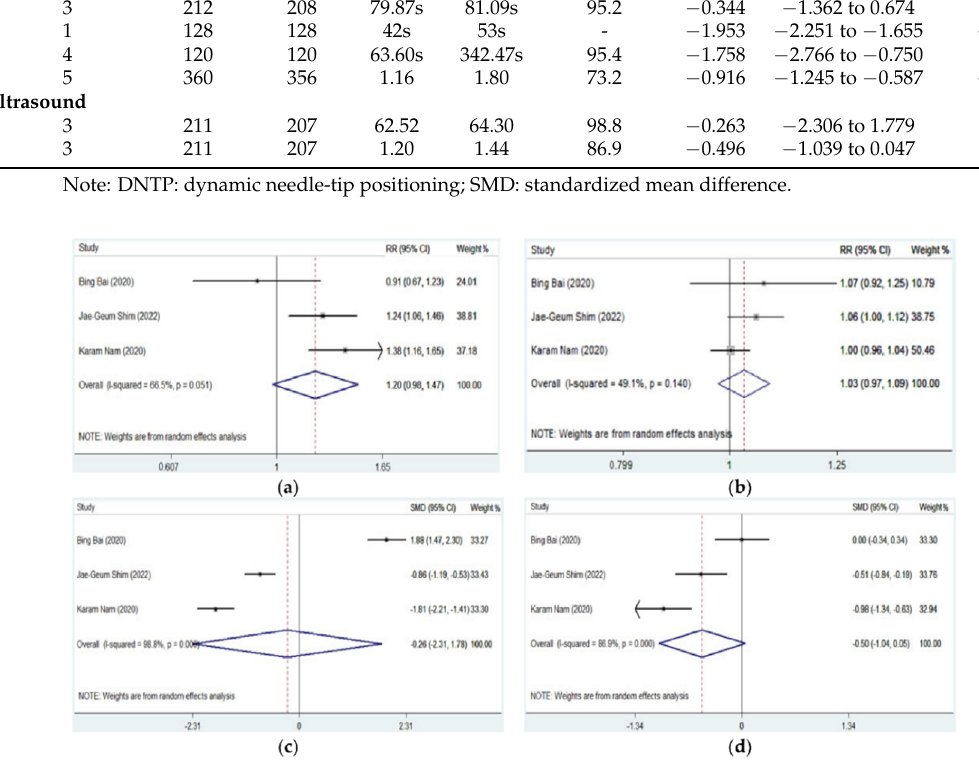
Figure 4. Forest plots for the efficiency outcomes of artery catheterization guided by DNTP vs. traditional ultrasound approach [9,10,16]. ( a ) First-attempt success of DNTP vs. traditional ultrasound; ( b ) overall success of DNTP vs. traditional ultrasound; ( c ) cannulation time of DNTP vs. traditional ultrasound; ( d ) puncture number of DNTP vs. traditional ultrasound.